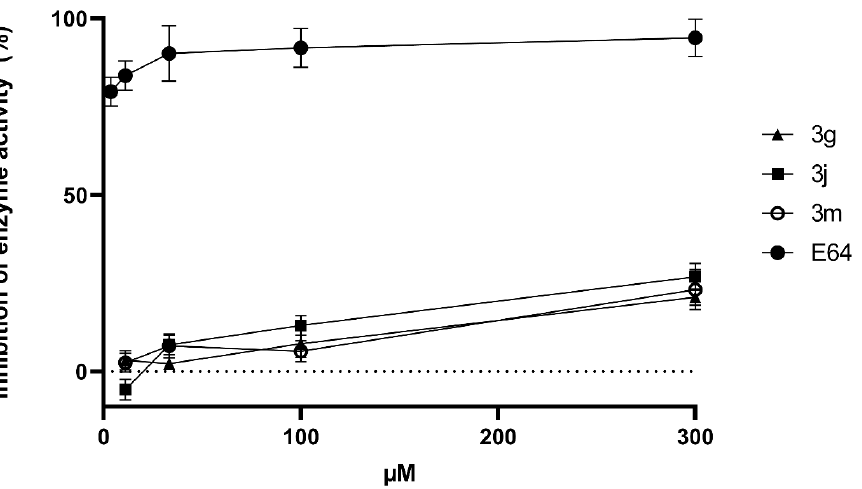
Figure 6. Inhibition of T. cruzi cysteine protease activity. Total protein extracts of trypomastigotes (5 µ g), was incubated at different concentrations (300–11.11 µ M) of compounds E64 (black circle), 3g (black triangle), 3j (black square) and 3m (white circle) in enzyme activation buffer pH 5.0, at 37 °C. Enzyme activity was measured using a specific fluorogenic peptide substrate Z-FR-AMC (60 µ M). Results are presented as percentage of inhibition of enzyme activity (%) and represent the mean and standard deviation (±) of three independent experiments. Hence, 100% of activity is relative to 0.22 μ mol min − 1 μ g of protein − 1 .